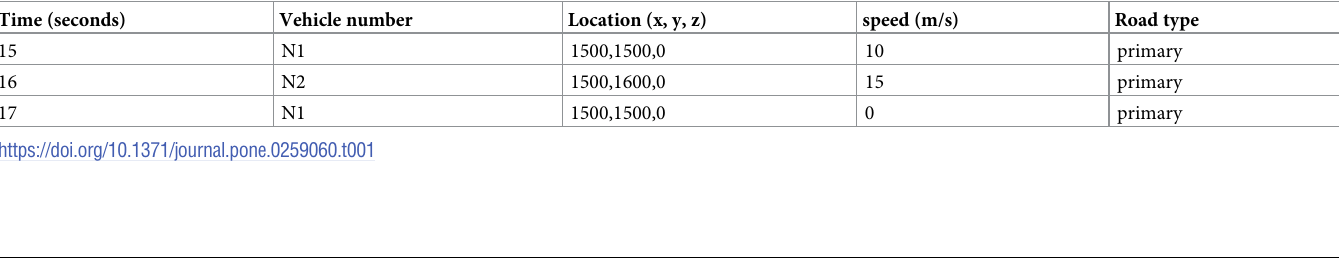
Table 1. Example row from TLILS passing location table